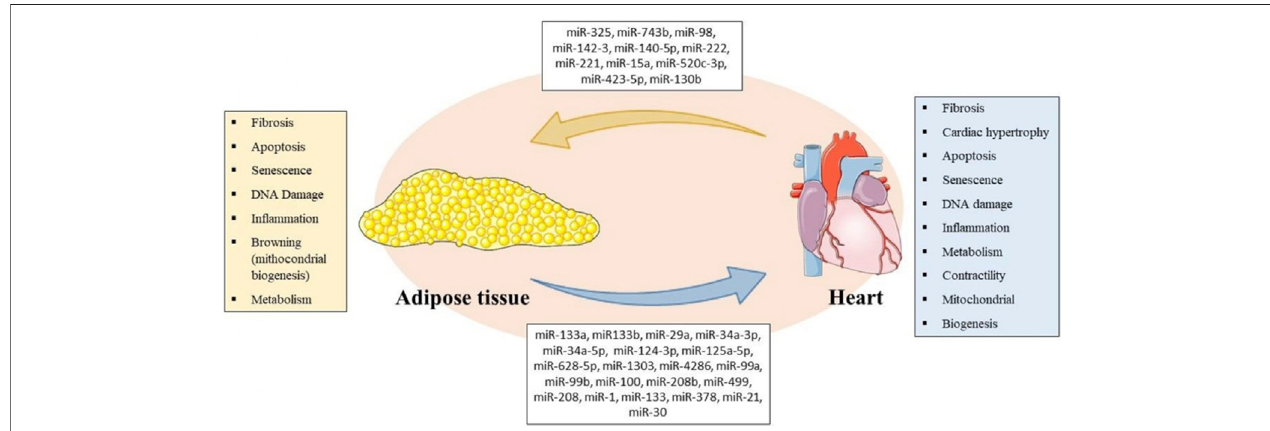
FIGURE 1 | Representative Scheme of miRNAs secreted by AT and heart with their respective biological processes involved in bidirectional crosstalk between tissues. Parts of the fi gure were drawn using pictures from Servier Medical Art (https://smart.servier.com/). Servier Medical Art by Servier is licensed under a Creative Commons Attribution 3.0 Unported